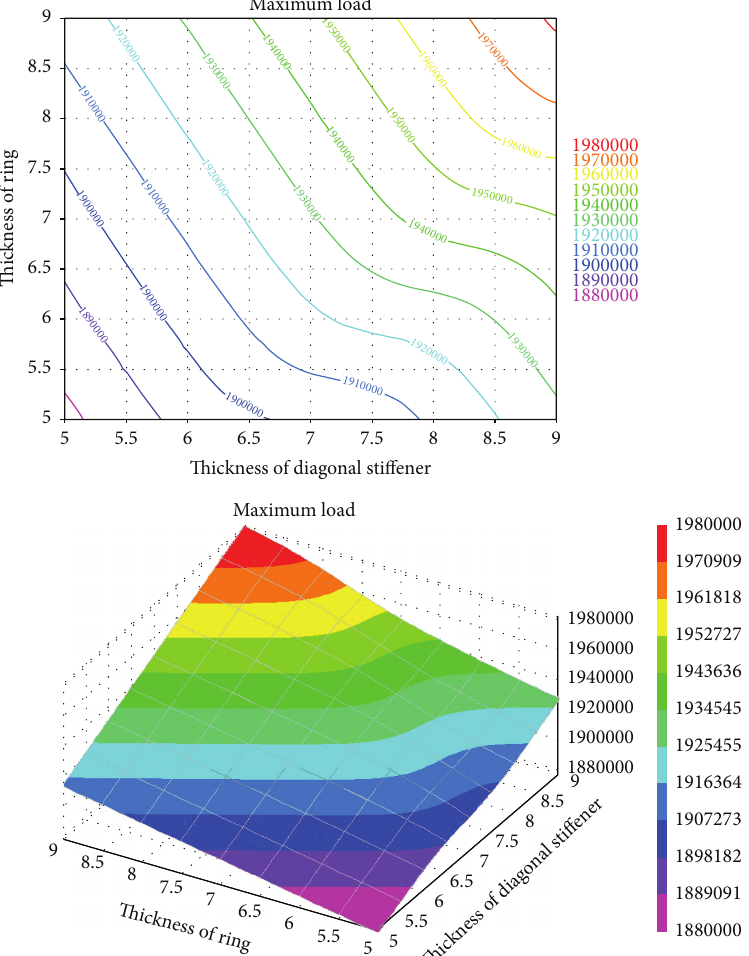
Figure 6: Obtained maximum load according to the thickness of ring and thickness of stiffener when the location of opening is down and thickness of plate is